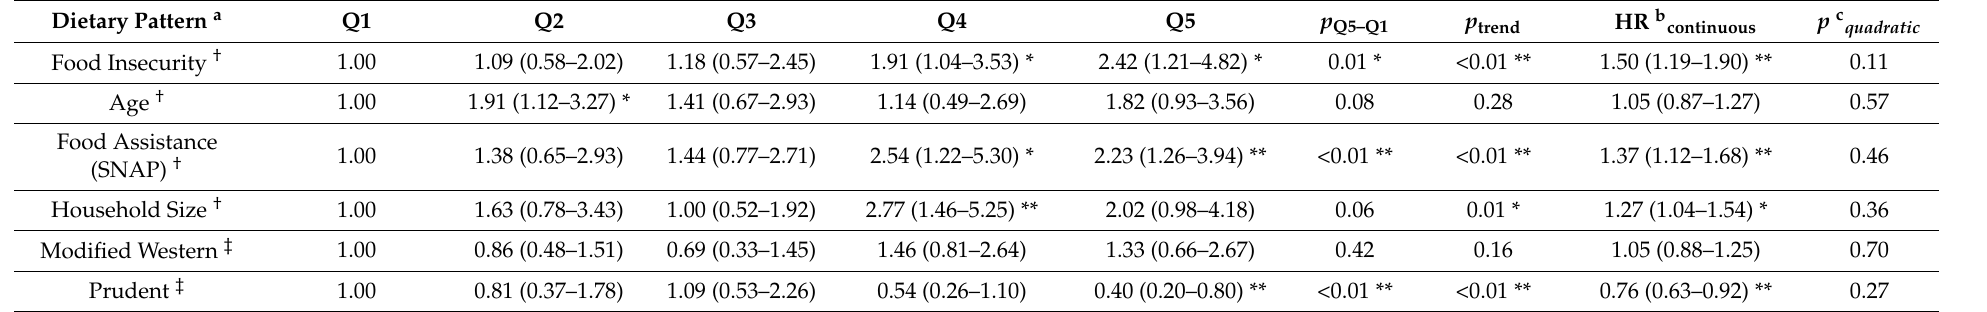
Table 4. Odds ratios and 95% confidence intervals for the relationship between the dietary patterns scores and the odds of being food insecure. There were 3317 cancer survivors (subsample A in Figure 1) that contributed to this